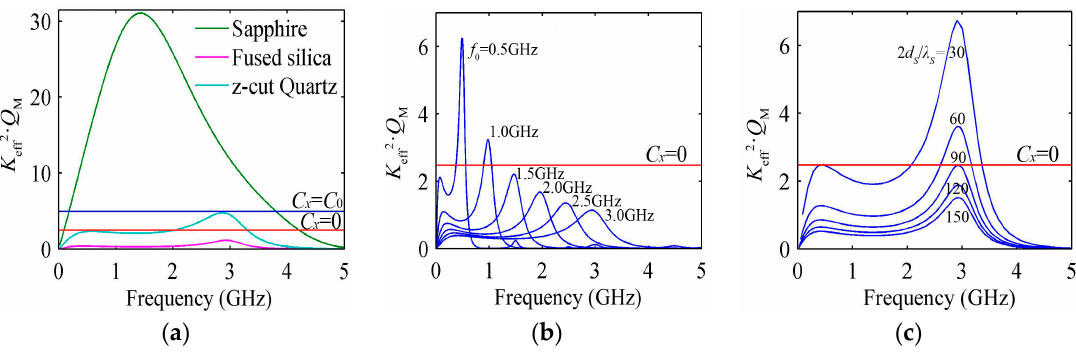
Figure 9. The variation curve of K eff 2 · Q M with the resonance frequency; ( a ) The HBARs consisting of ZnO/substrate; ( b ) The different operating frequency using fused silica as substrate; ( c ) The different thickness of fused silica substrate.